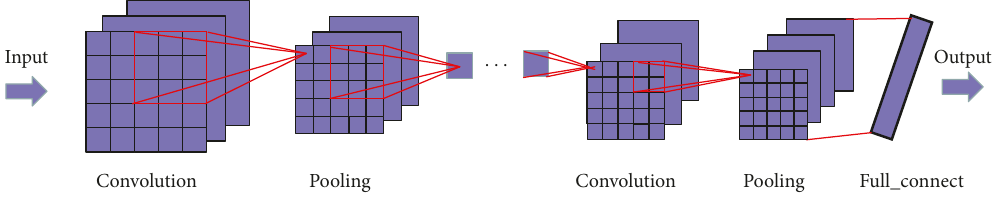
Figure 8: Neural network structure for predicting the composition of steel